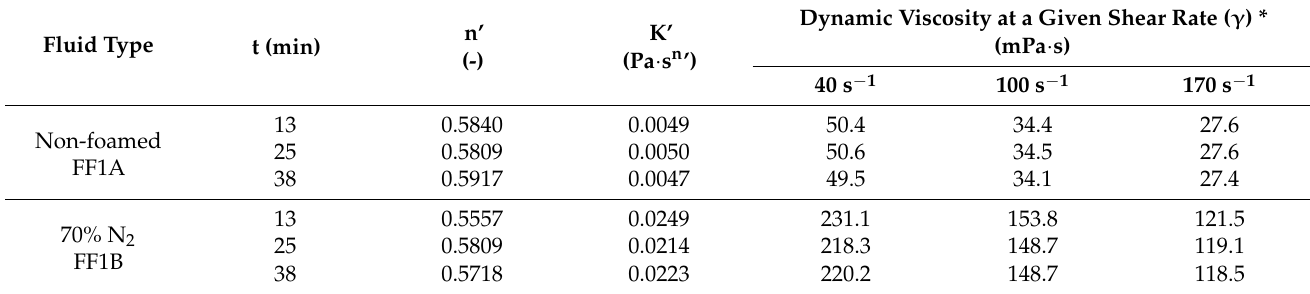
Table 4. Rheological parameters of non-foamed fluids (FF1A) and fluids energized with N 2, foam quality of 70% (FF1B) at 60 ◦ C.